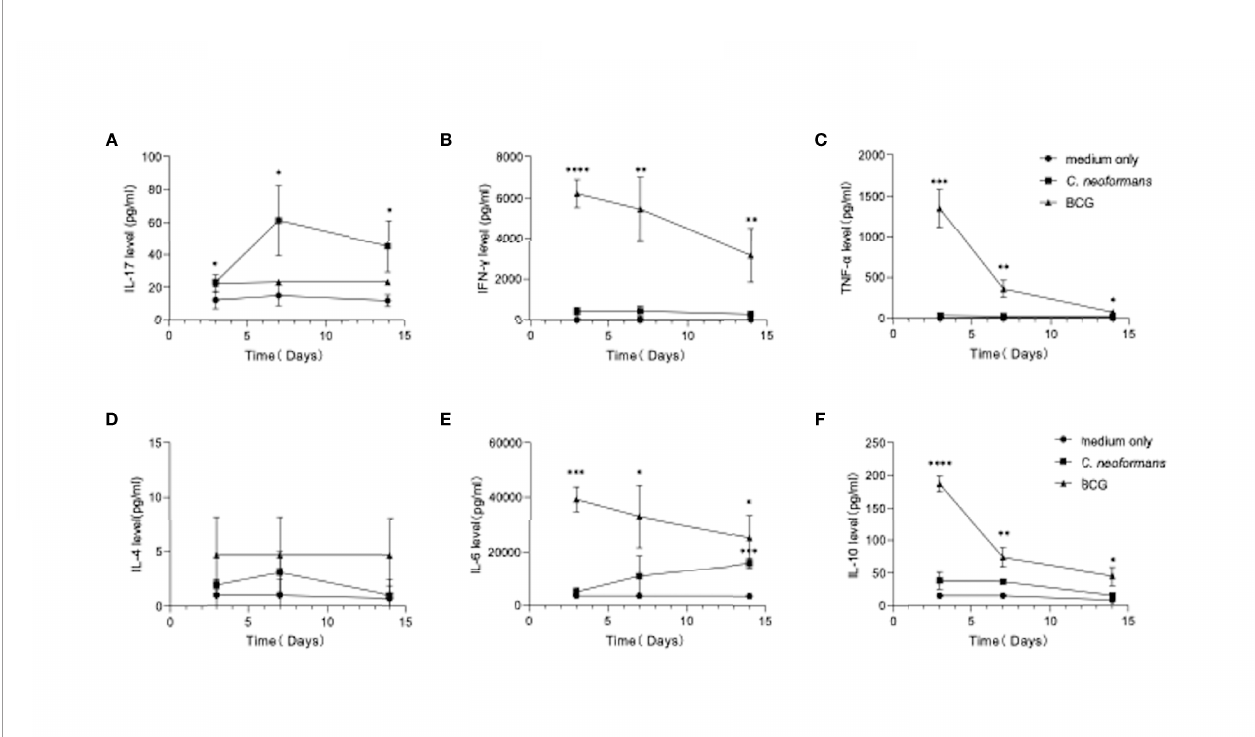
FIGURE 2 | Dynamics of cytokine production by peripheral blood mononuclear cells (PBMCs) in response to C. neoformans or bacillus Calmette – Gue ́ rin (BCG) stimulation. Healthy PBMCs were stimulated with C. neoformans or BCG for different times (day 3/7/14). The supernatant cytokine levels were measured by ELISA. The dynamics of IL-17 (A) , IFN- g (B) , TNF- a (C) , IL-4. (D) , IL-6 (E) , and IL-10 (F) are shown as mean ± SE of three individual experiments. *0.01<p<0.05, **0.001<p<0.01, ***<0.0001<p<0.001,